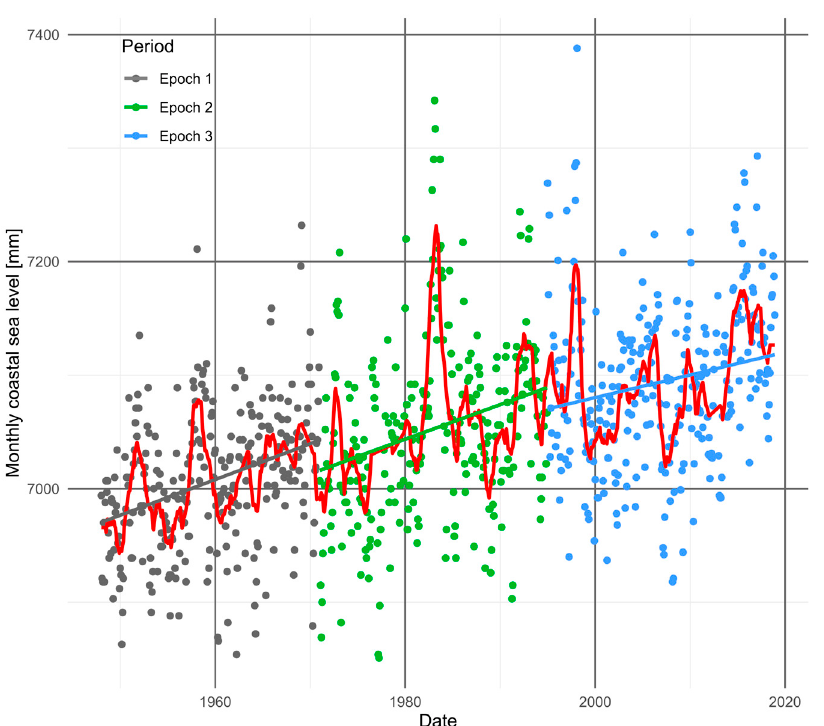
Figure 7. Coastal sea level trends at the San Francisco station for the periods 1948–1970 (grey), 1971–1994 (green), and 1995–2018 (blue). Observed records are represented by points, while the continuous red line depicts a smoothed output of the series using the LOWESS nonparametric regression approach.